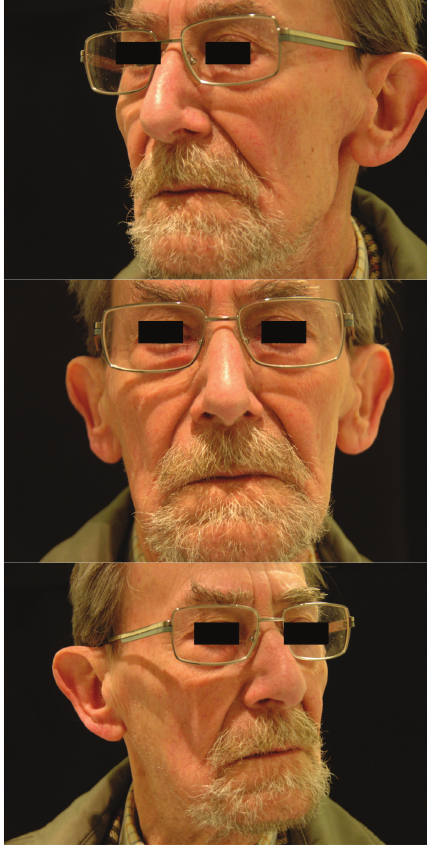
Figure3:This85year-oldmaleunderwentatotalleftparotidectomy with dissection and preservation of the facial nerve and a fat graft (10mLoffatfor51grresected).Follow-upat46monthsshowsavery good cosmetic result and no complain of gustatory sweat syndrome is experienced by the patient. At one year, the Minor’s starch-iodine test is negative.